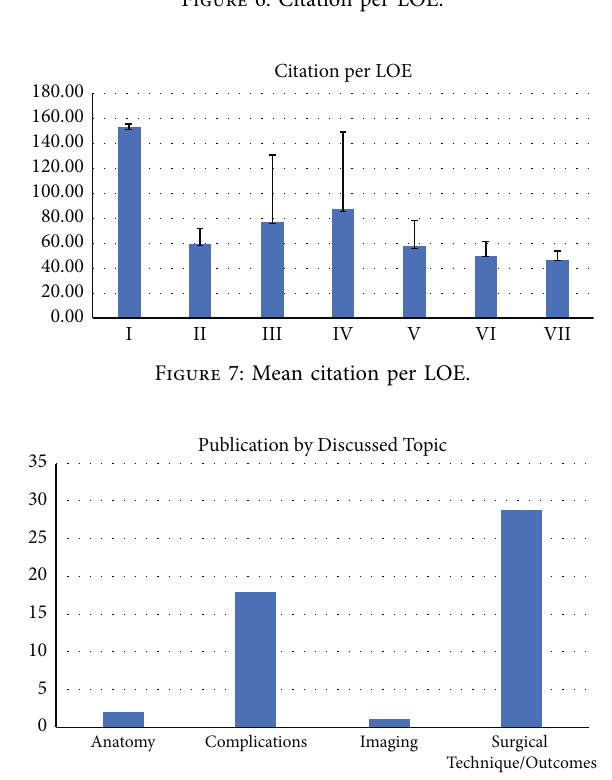
Figure 6: Citation per LOE.